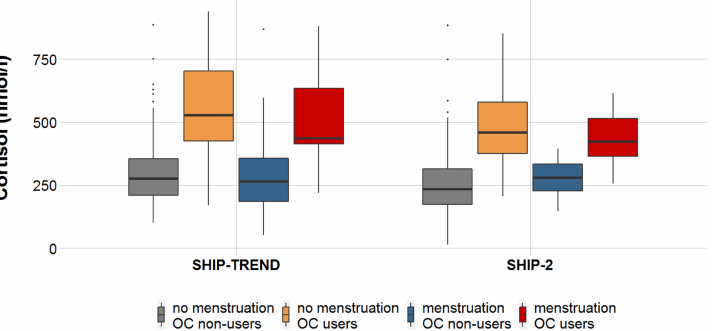
Figure 1. Boxplots are presented with the bold line symbolizing median serum cortisol concentrations and boxes summariz- ing the interquartile range. Whiskers represent concentrations lower than 25% and higher than 75%, respectively. Dots represent statistical outliers (M ± 3SD). Serum cortisol concentrations dependent on menstrual bleeding at the time of as- sessment and OC use are presented in both cohorts. Compared with nonmenstruating OC nonusers, both nonmenstruating and menstruating OC users had statistically higher cortisol concentrations in SHIP–TREND (nonmenstruating OC users: β = 0.551, t = 9.721, p = 1.02 × 10 − 18 ; menstruating OC users: β = 0.160, t = 2.638, p = 0.009) and SHIP–2 (nonmenstruating OC users: β = 0.475, t = 6.576, p = 8.32 × 10 − 10 ; menstruating OC users: β = 0.186, t = 4.939, p = 2.15 × 10 − 6 ). However, no statistical differences were observed between nonmenstruating and menstruating OC nonusers in SHIP–TREND ( β = 0.022, t = 0.433, p = 0.665) or SHIP–2 ( β = 0.035, t = 0.688, p =